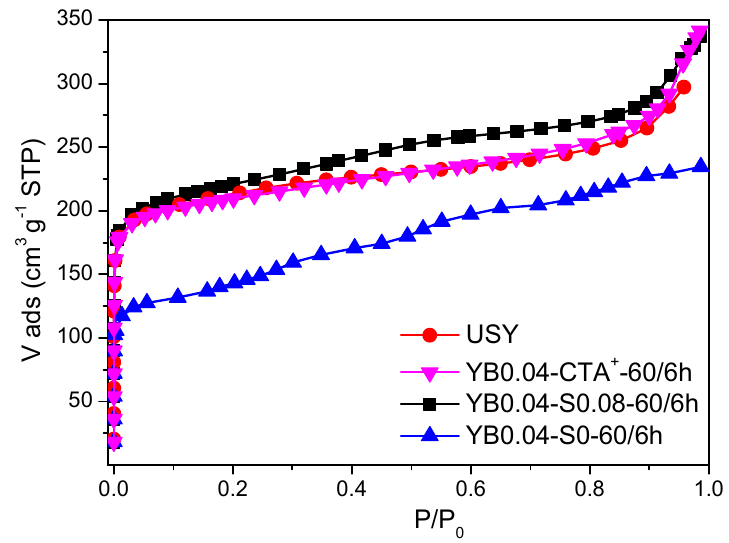
Figure 14. Nitrogen adsorption isotherms for the zeolite samples used to evaluate the effect of the presence of CTA + .